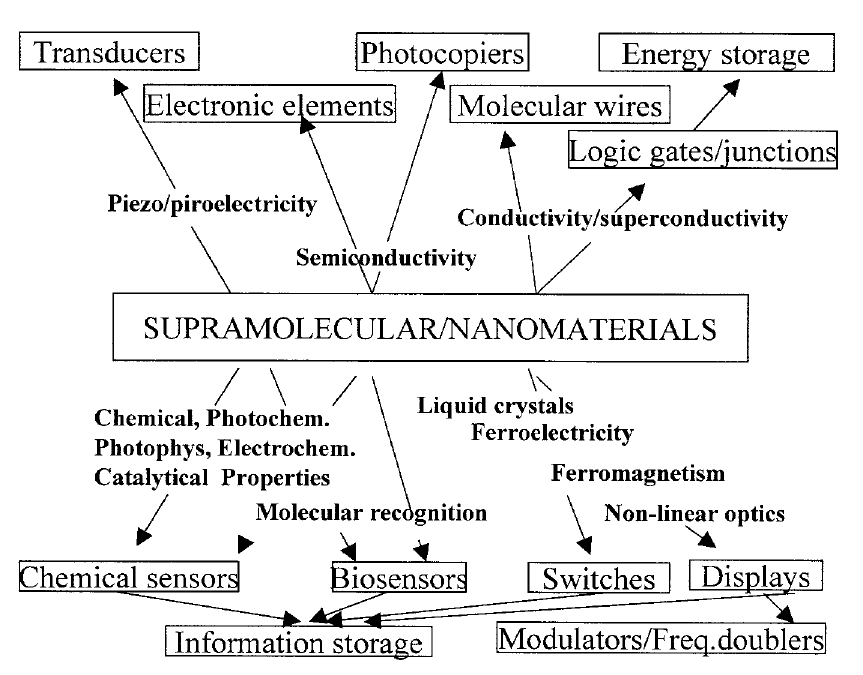
Fig. 1 – Properties and technological applications of supramolecular and